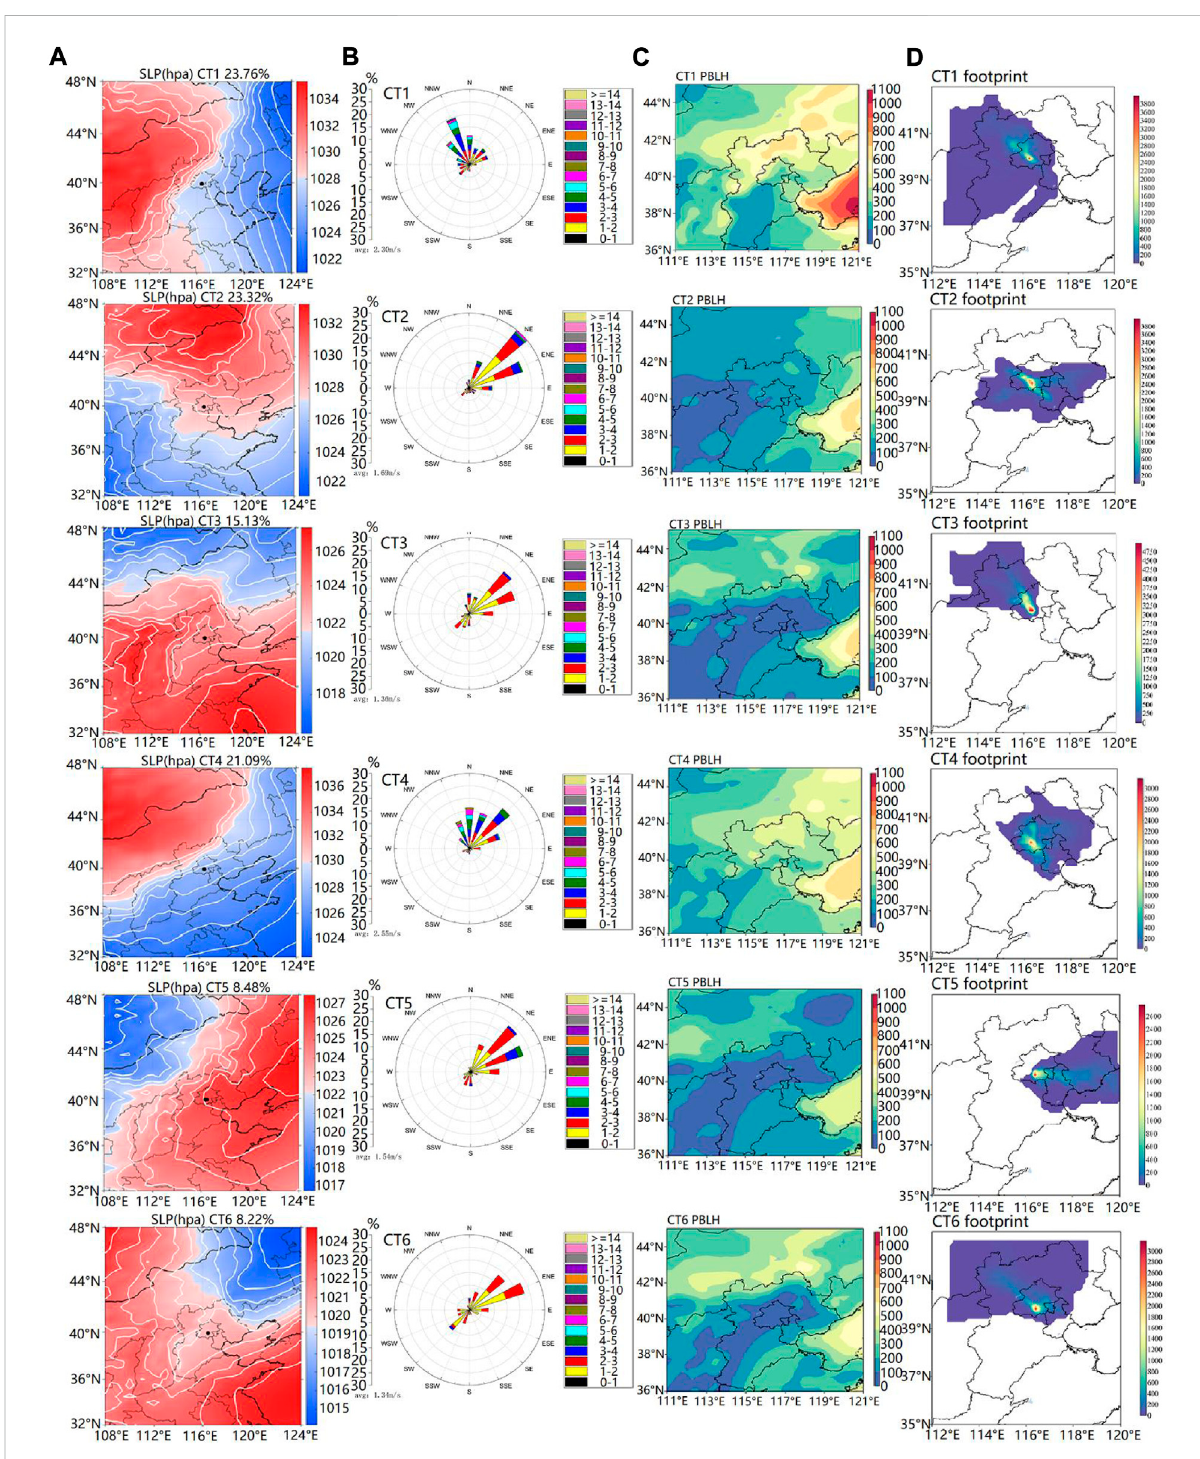
FIGURE 3 (A) Six main weather circulation patterns affecting the Beijing area, (B) local wind fi eld under the six circulation patterns (unit: m/s), (C) height (unit: m) distribution of planetary boundary layer under the six circulation patterns, (D) 48 h backward footprint (unit: sm 3 kg − 1 ) under the six circulation patterns simulated by